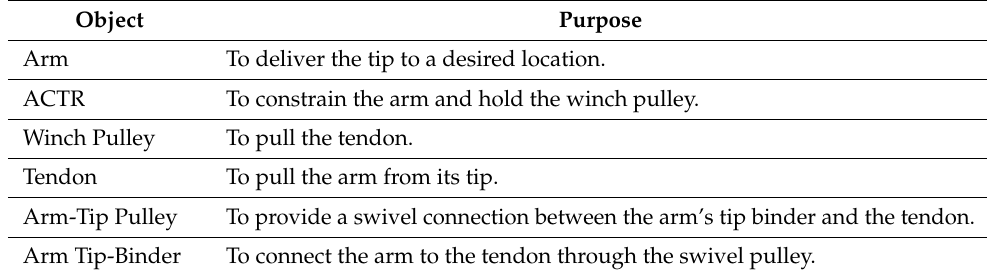
Table 1. List of parts and their purpose in the FEA simulation.